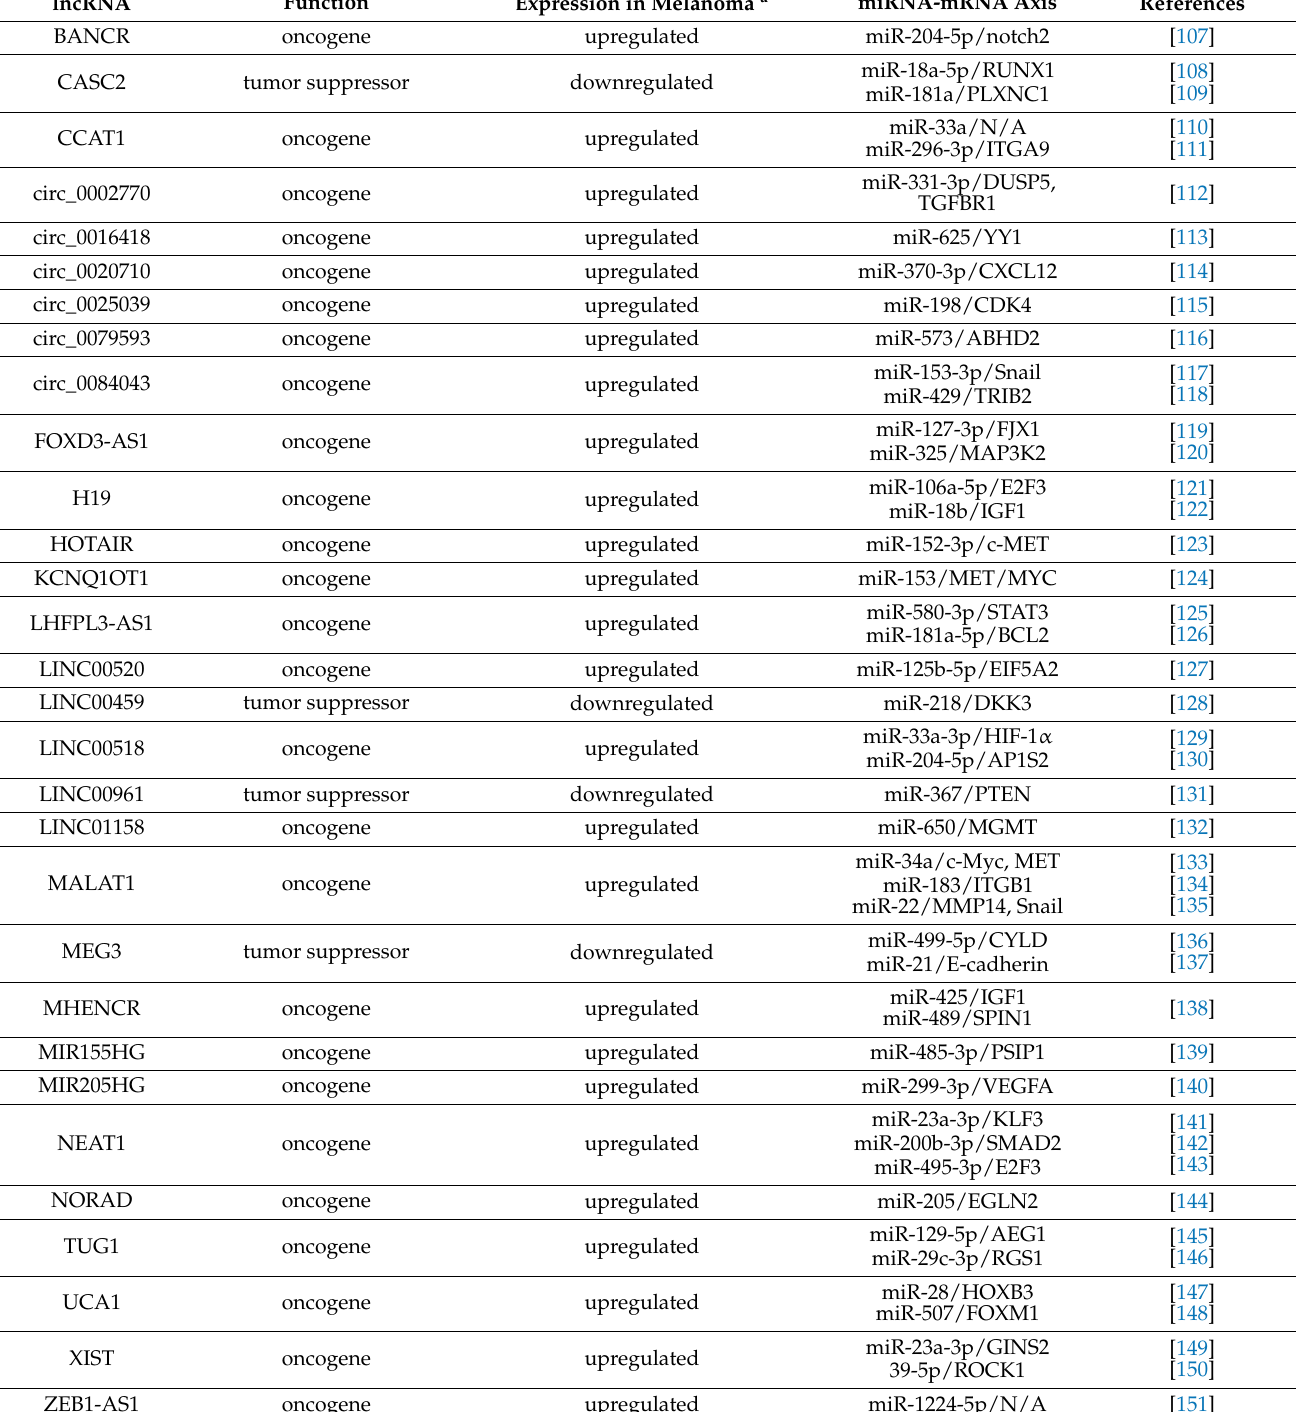
Table 2. lncRNA and circRNAs with miRNA sponging activity in